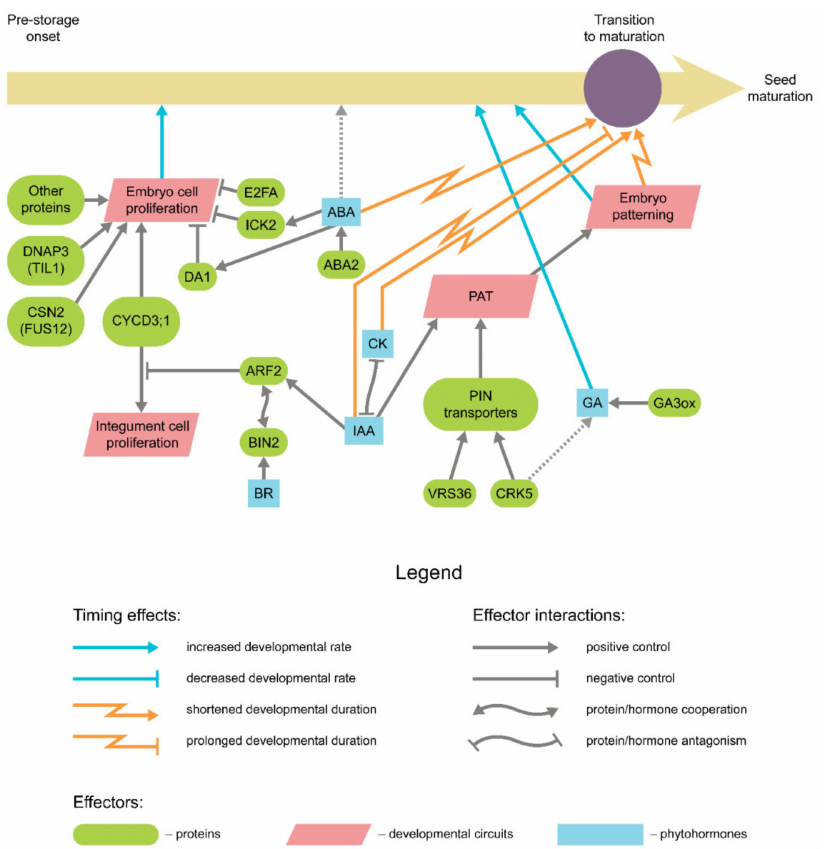
Figure 2. Main genetic and hormonal factors affecting pre-storage progression in dicots. For arrow shape and color meaning, see the figure legend. Abbreviations stand for: IAA —auxin, CK —cytokinin, ABA —abscisic acid, GA —gibberellin. The promoting effect of ABA on cell proliferation was proposed in references [53,54]. For CRK5-mediated coupling of IAA and GA signaling, see reference [55]. PAT— polar auxin